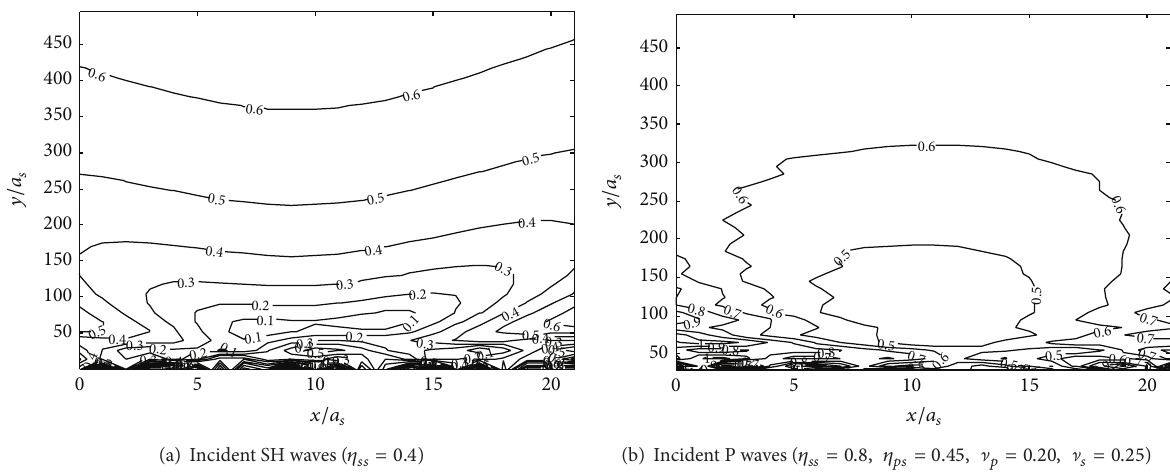
Figure 12: Contours of normalized displacement amplitudes by multirows of tubular piles ( 𝑏 𝑠 = 0.9𝑎 𝑠 , 𝑠 𝑝 = 3.0𝑎 𝑠 , ℎ = 3.0𝑎 𝑠 , 𝐺 𝑟 = 10, 𝑚 = 4, 𝑁 = 12 ).